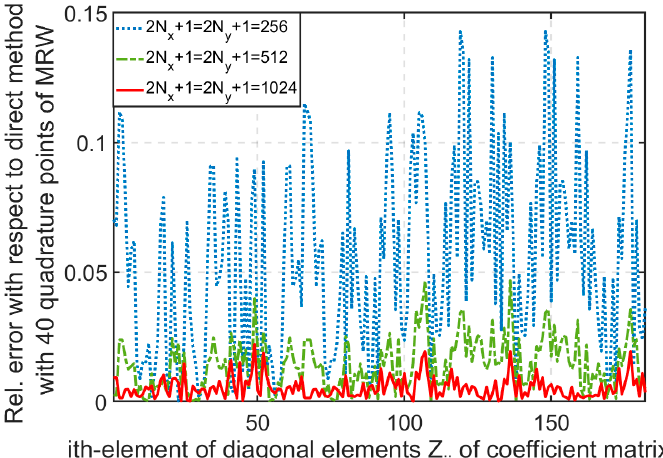
Figure 6. Relative error of the computation of the diagonal elements, Z ii , provided by the method proposed in Equations (6), (12) and (13) with respect to the direct method given by the direct computation of Equations (6)–(8) using MRW quadrature rules with 40 × 40 quadrature points. The relative errors are shown for di ff erent values of the size of the equi-spaced mesh (2N x + 1) × (2N y + 1). The results were obtained at 10 GHz for L 1 = 4.1365 mm under oblique incidence given by θ inc = 20 deg and φ inc = 0